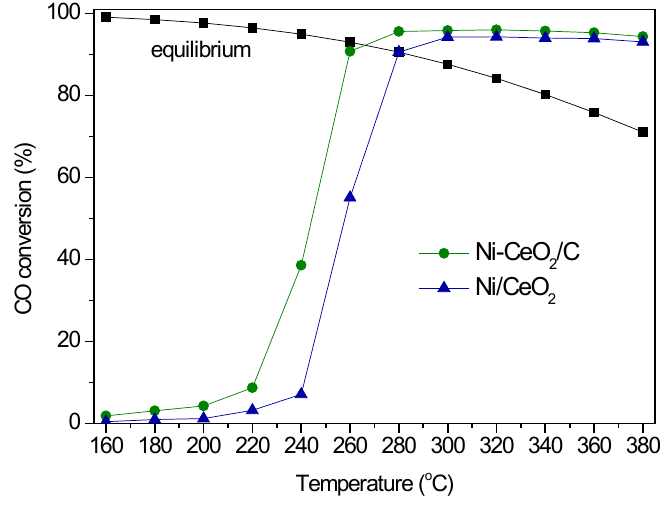
Figure 2. CO conversion vs. reaction temperature for catalysts reduced at 350 °C.